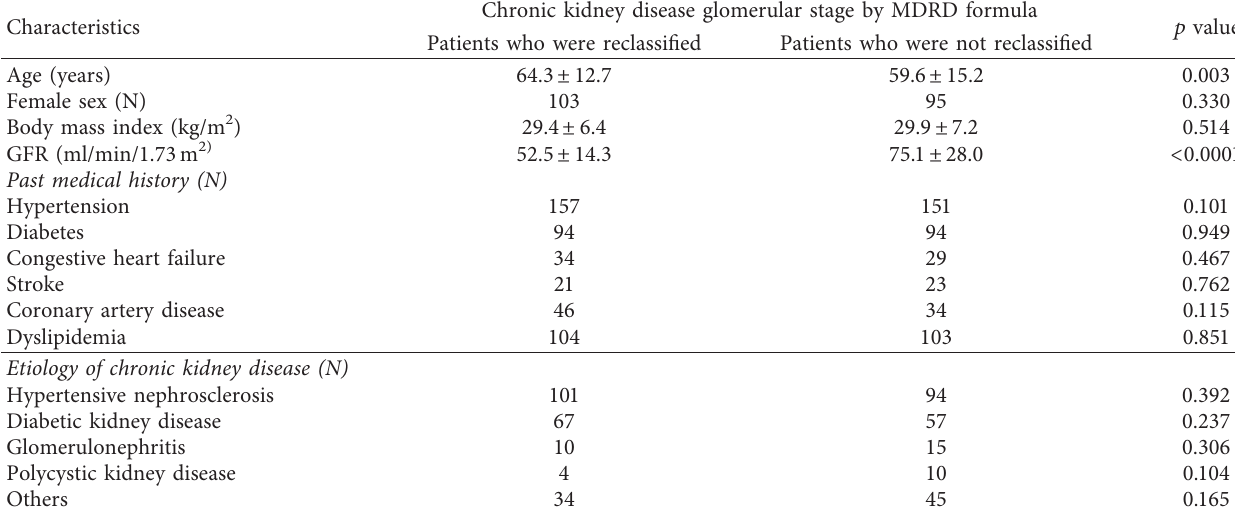
Table 6: Comparison of AA patient characteristics of those were reclassified after removal of the race